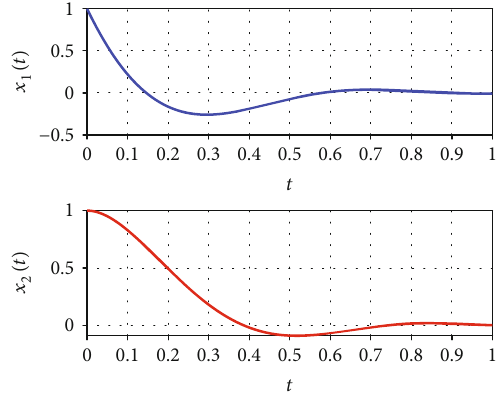
Figure 2: Stability diagram of Example 19 for x